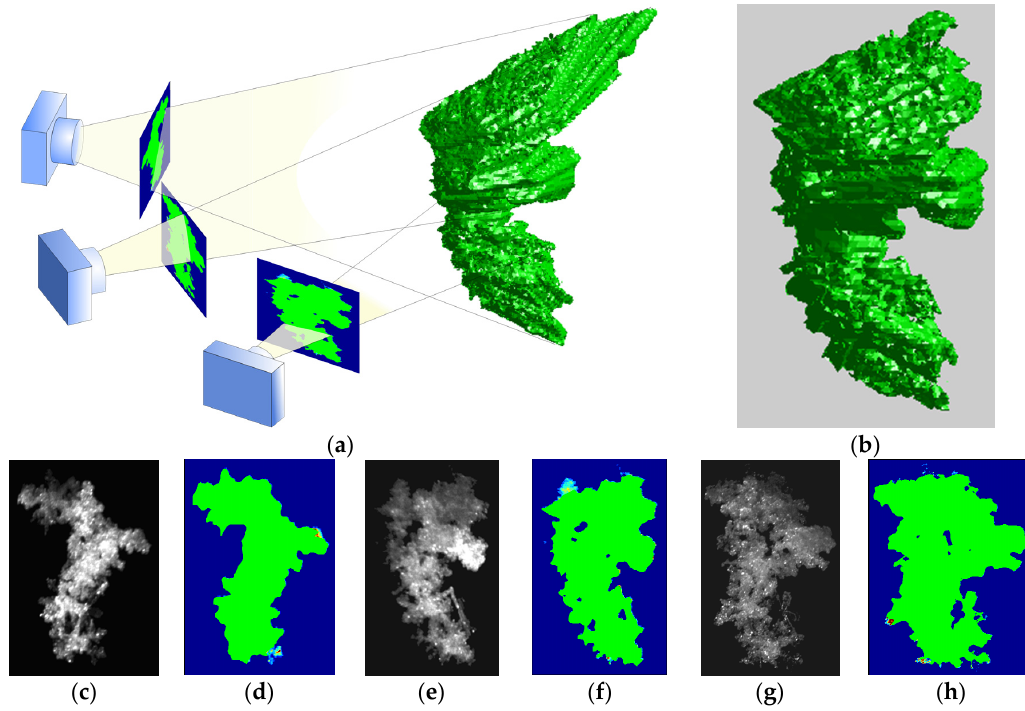
Figure 3. Illustration of MASC-VHMC snowflake measurement-reconstruction: ( a ) visual hull (VHMC) reconstruction of the 3D shape of a snowflake based on MASC (Figure 1) photographs and the corresponding 2D silhouettes of the object; ( b ) triangular 3D mesh of the reconstructed snowflake; ( c ), ( d ) MASC photograph and corresponding projection of the VHMC-generated 3D mesh in ( b ) to the camera image plane in ( a ) for the first camera; ( e ), ( f ) MASC photograph and mesh projection for the second camera; ( g ), ( h ) photograph and projection for the third camera.